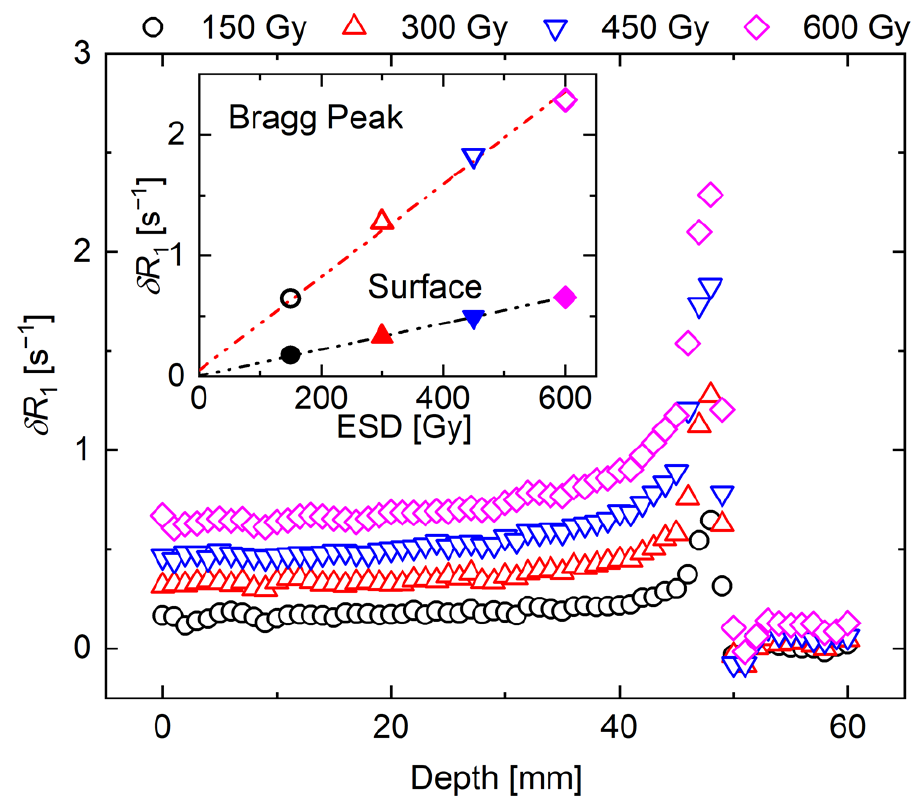
Figure 3. One-line depth- δ R 1 distribution in NC-FG dosimeter. The inset shows R 1 values [s − 1 ] as a function of the ESD [Gy] at the entrance surface (solid symbol) and at the Bragg peak (open symbol). The ESD values are 150 (circle), 300 (upper triangle), 450 (lower triangle), and 600 (rhombus) Gy.